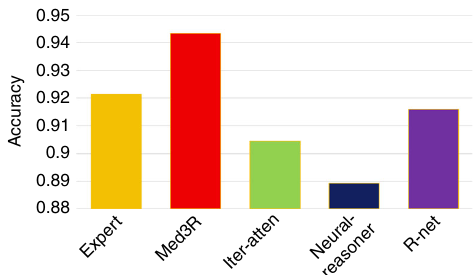
Fig. 3 Comparison results of Med3R with baselines on clinical diagnosis. Med3R: our proposed NMLEC system fi ne-tuned on EMR data; expert: average accuracy of four medical experts; Iter-atten: iterative attention model 4 ; Neural-reasoner: neural reasoner model 3 ; and R-net: r-net model 2 . All baseline models are trained on the same data as used in Med3R